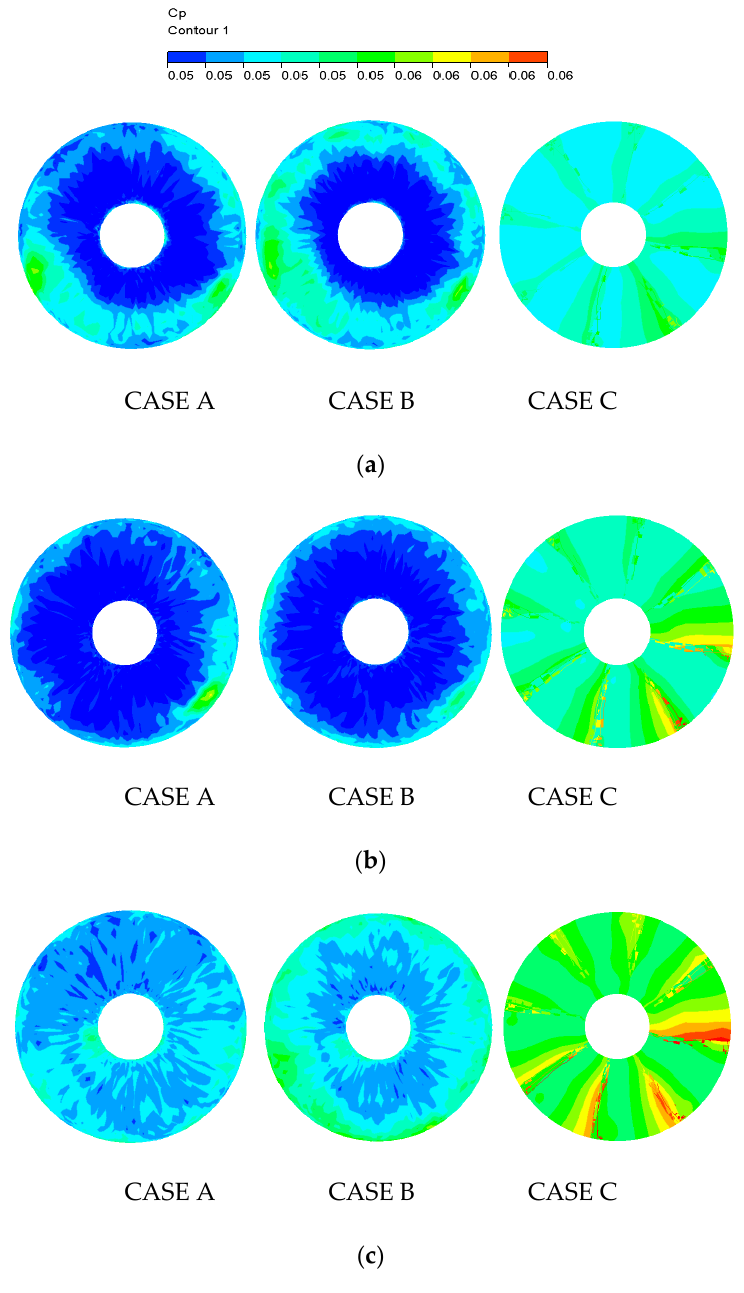
Figure 14. Pressure distribution within the outlet pipe of optimized cases A, B and C under flow conditions of: ( a ) 1.0 Q d ( b ) 1.2 Q d and ( c ) 1.4 Q d .